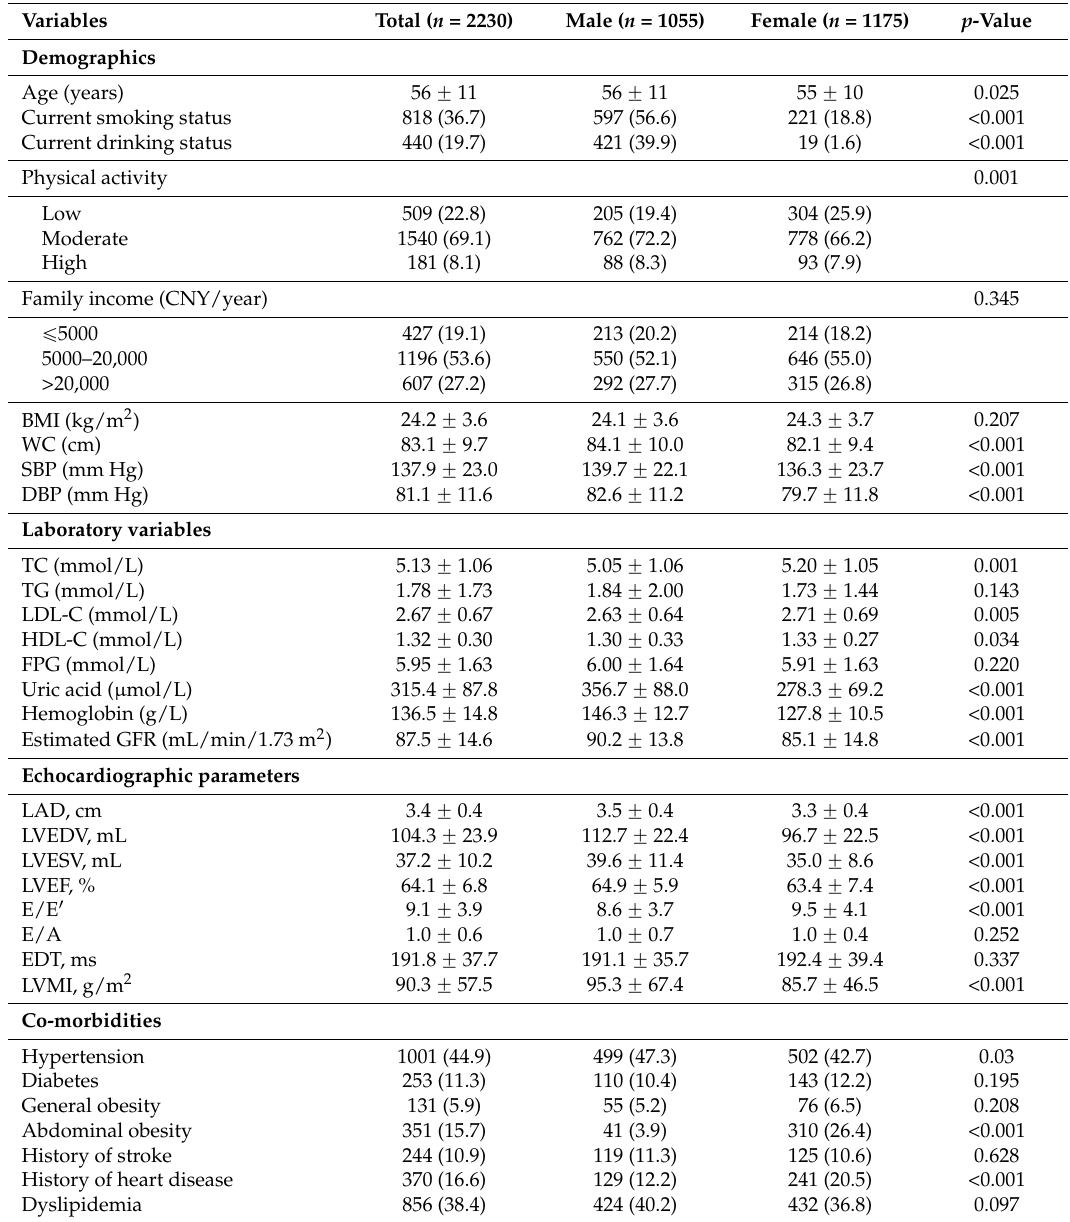
Table 1. Baseline characteristics of the study